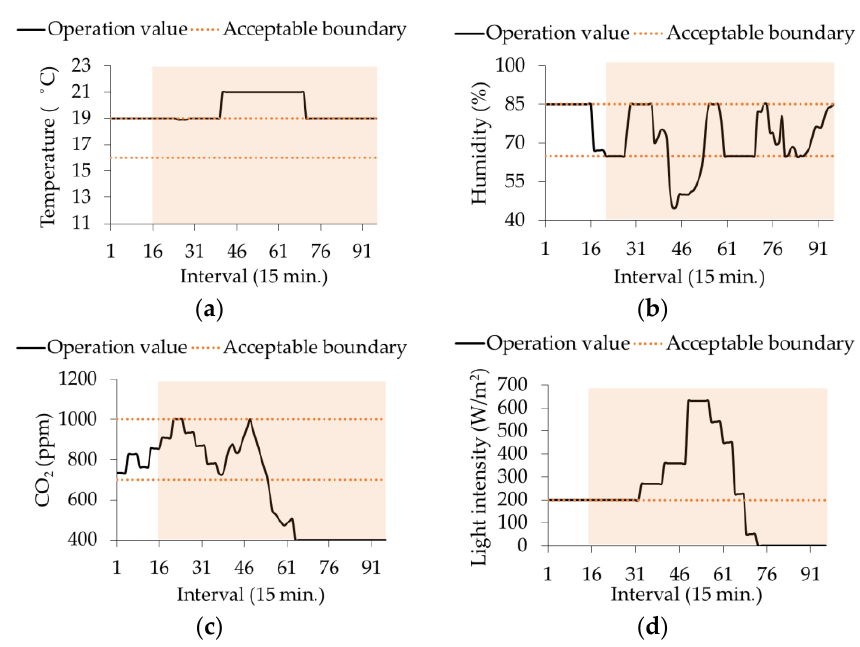
Figure 7. Environmental control of a building microgrid with rooftop greenhouse: ( a ) Temperature; ( b ) Humidity; ( c ) CO 2 concentration; ( d ) Light intensity.